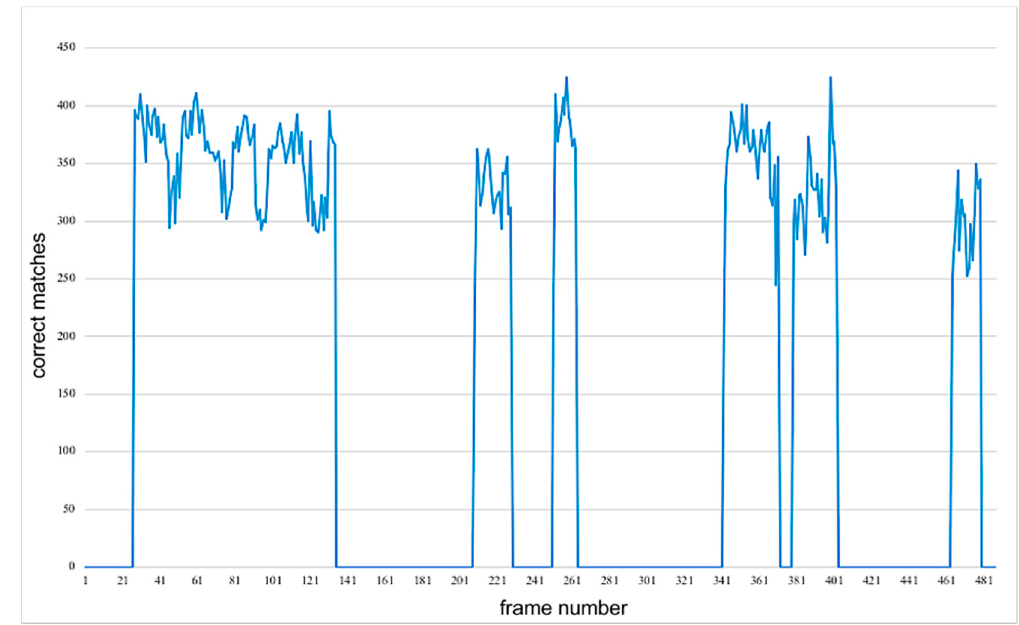
Figure 12. The number of correctly matched features in 481 frames.